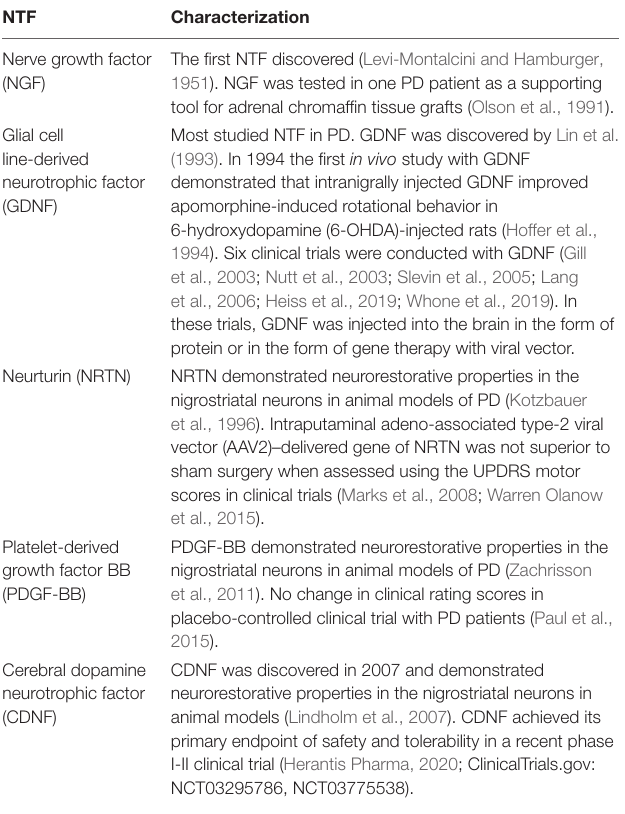
TABLE 1 | Neurotrophic factors (NTFs) used in PD